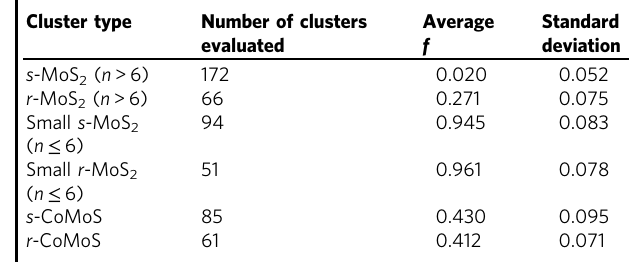
Table 1 Scheme of the statistical details on the data of shape factor, f ,